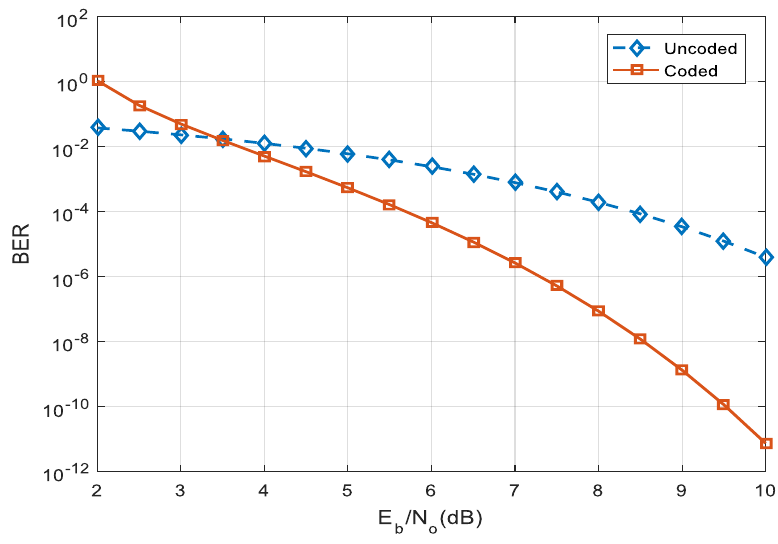
Figure 8. The BER (Bit Error Rate) under different encoding.